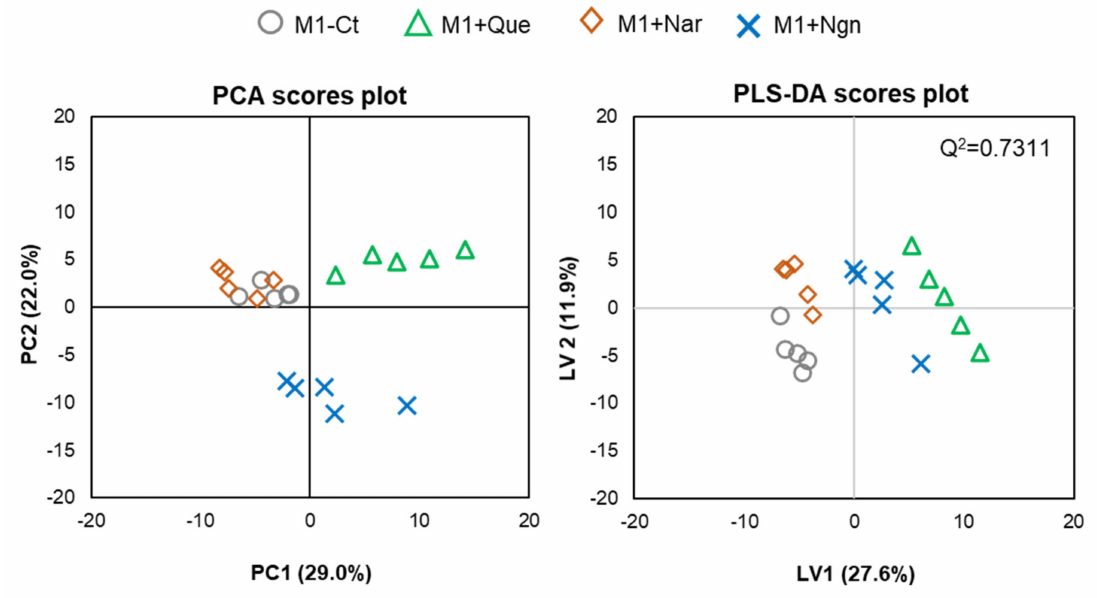
Figure 4. Multivariate analysis of LC-MS data collected for M1 macrophages exposed to di ff erent flavonoids: PCA (left) and PLS-DA (right) scores scatter